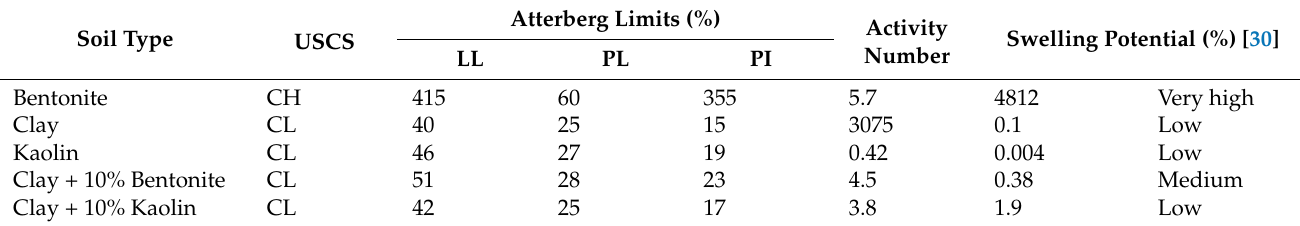
Table 2. Results of the geo-engineering description ofthe studied clayey soil.